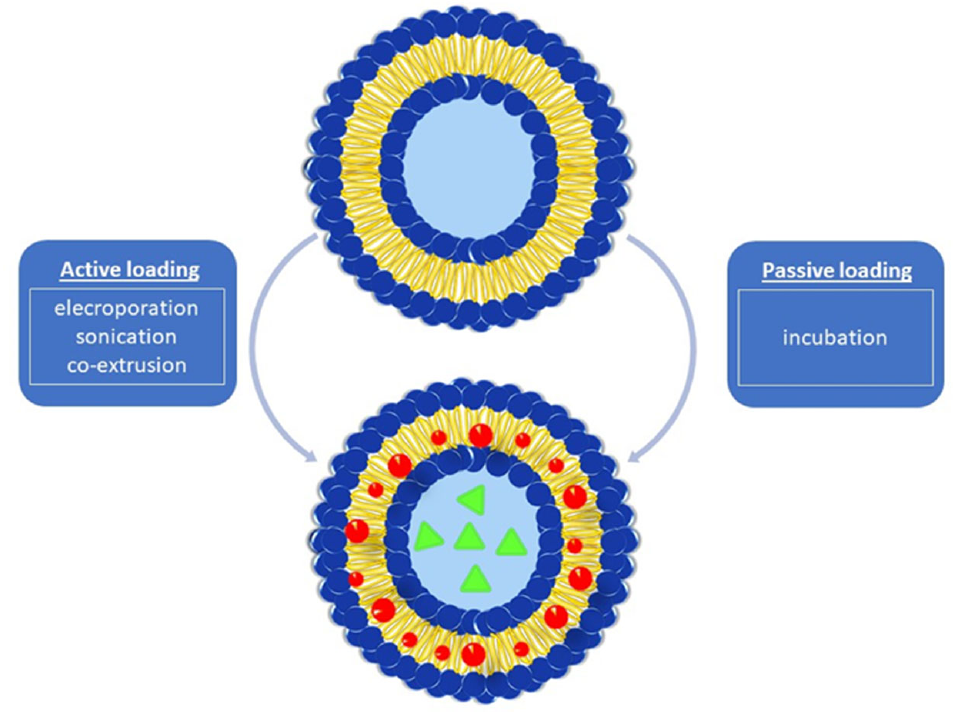
Figure 2. Drug loading approaches into BMVs .